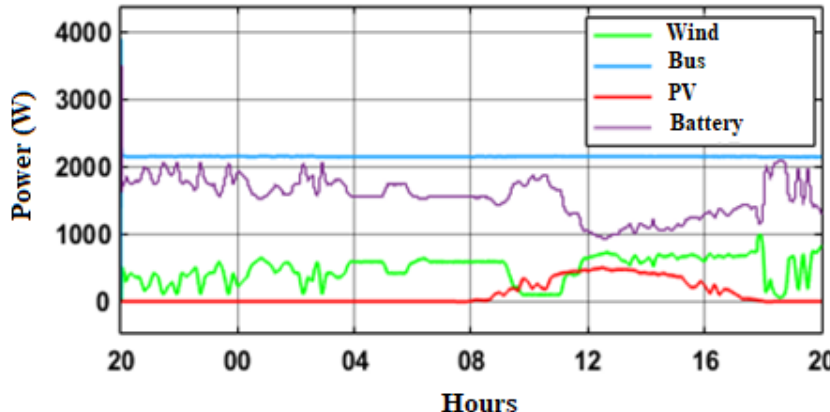
Figure 20. Power delivered by different sources of the MSPS and BESS.